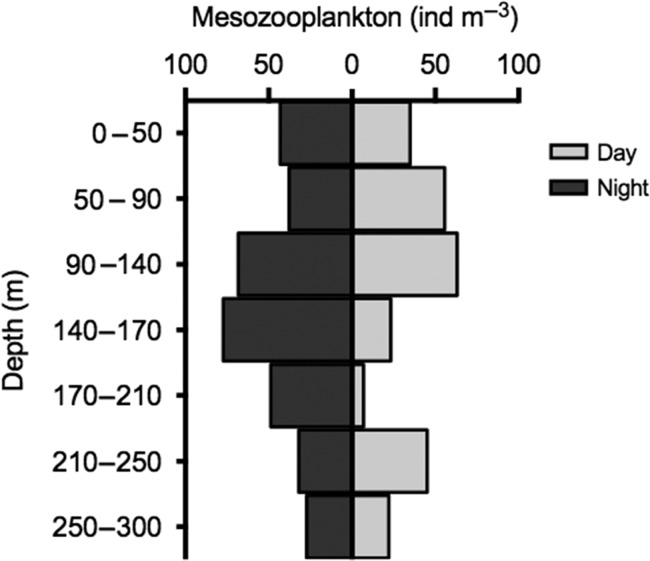
Depth distribution of Lurefjorden mesozooplankton (ind m−3) collected via a Kiel MultiNet during day (light bars) and night (dark bars) periods on 8 February 2010. Weighted mean depth ± standard deviation for day and night was 188.8 ± 113.4 m and 183.5 ± m 119.5 m, respectively. See Table I for sampling parameters.